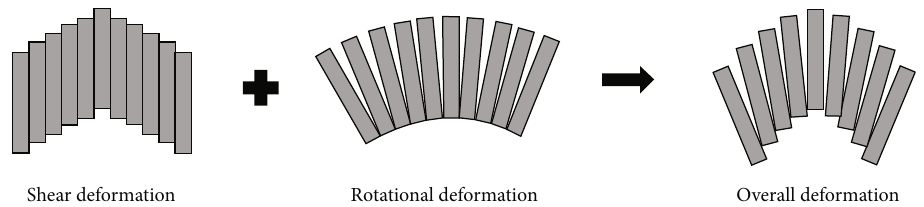
Figure 7: Shear stagger model.